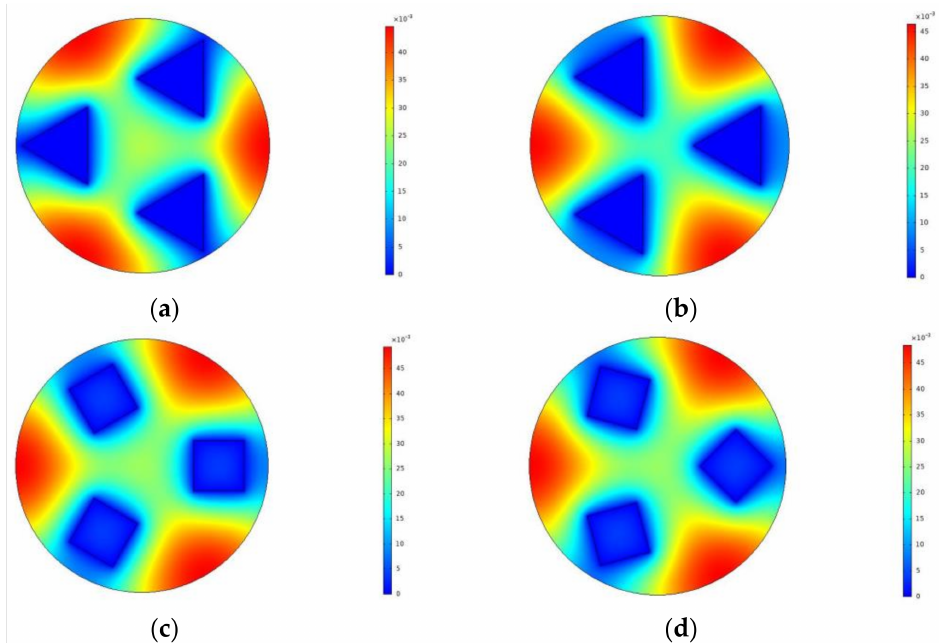
Figure 11. The dimensionless temperature cloud charts of four models when N = 6, ϕ = 15% and (cid:101) d = 0.344147. Where subfigures ( a – d ) are Model 1, 2, 3 and 4